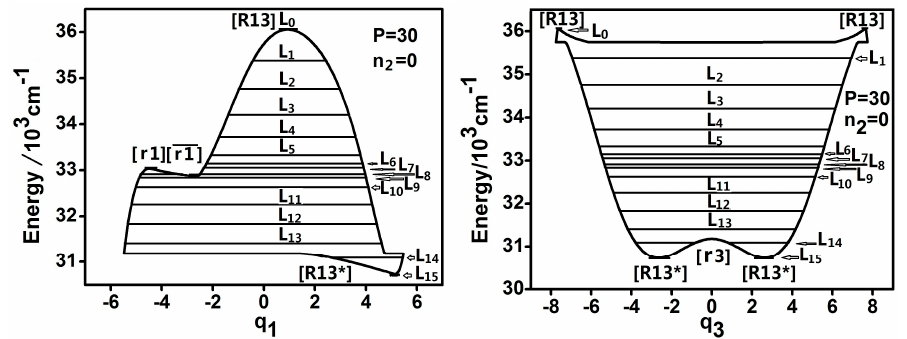
n = 0 and the energy levels included in the 2